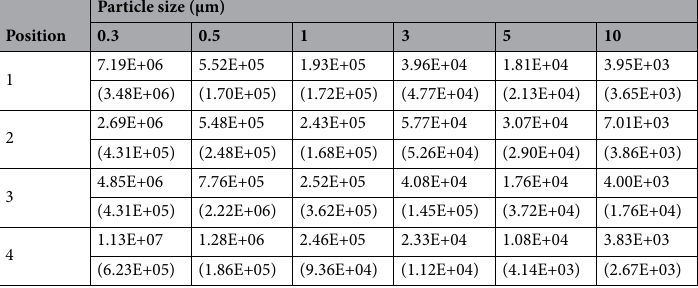
Table 2. Arithmetic mean (SD) particle count detected at Height 0.15 m across all positions and particle size.